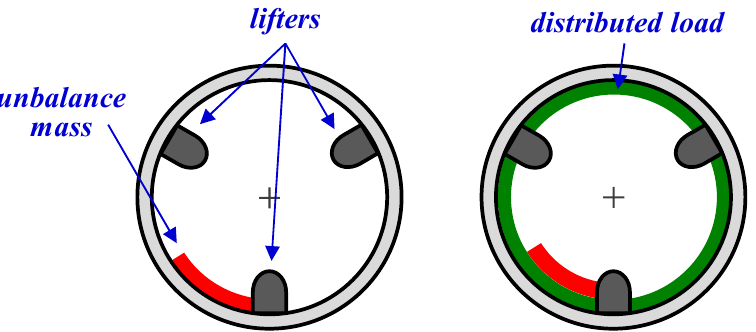
Figure 2. Emulation of the unbalance mass using specific rubber plates. These are also used to simulate a distributed load, thereby testing different values of the overall laundry inertia.